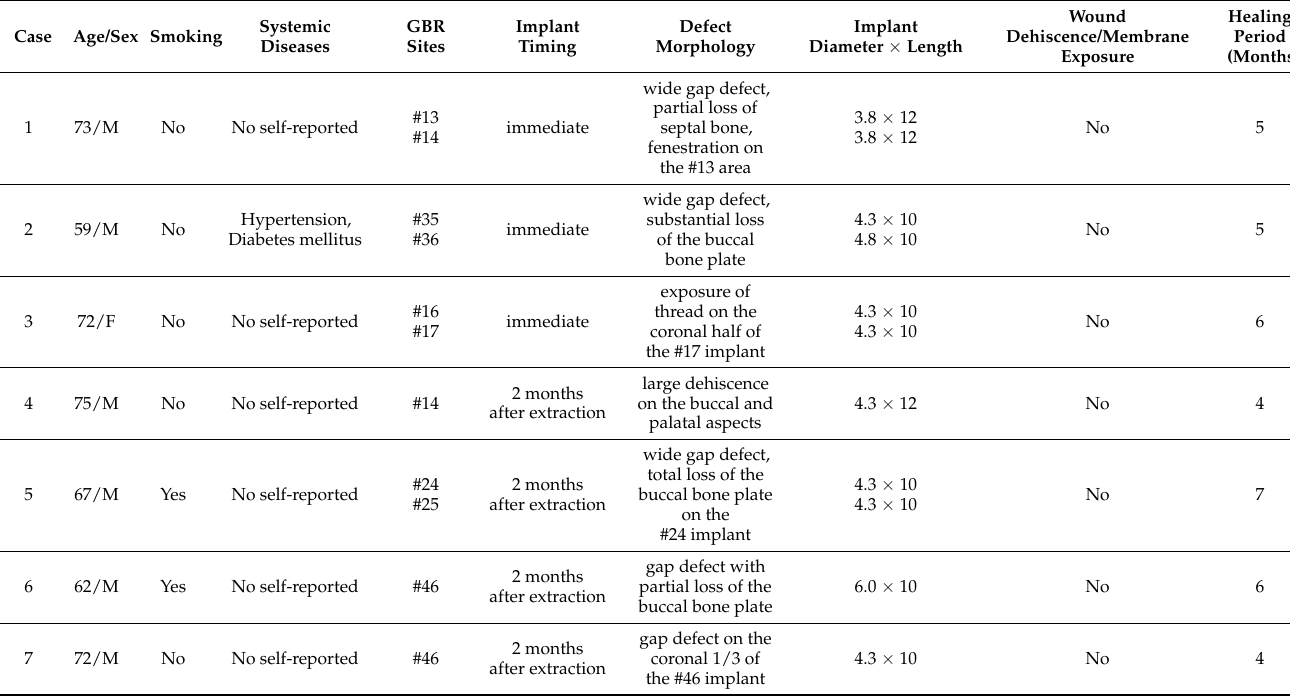
Table 1. Demographic information of the included